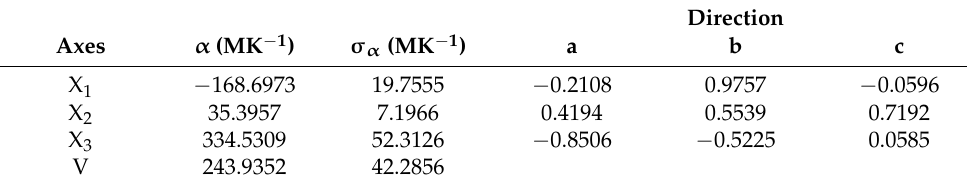
Figure 7. Temperature-dependent crystallographic parameters a ( a ), b ( b ) and c ( c ) axes and the expansivity indicatrices ( d ) of TMP-OA; purple and yellow represent positive and negative thermal expansion, respectively. Table 2. Calculated thermal expansion coe ffi cients for TMP-OA.